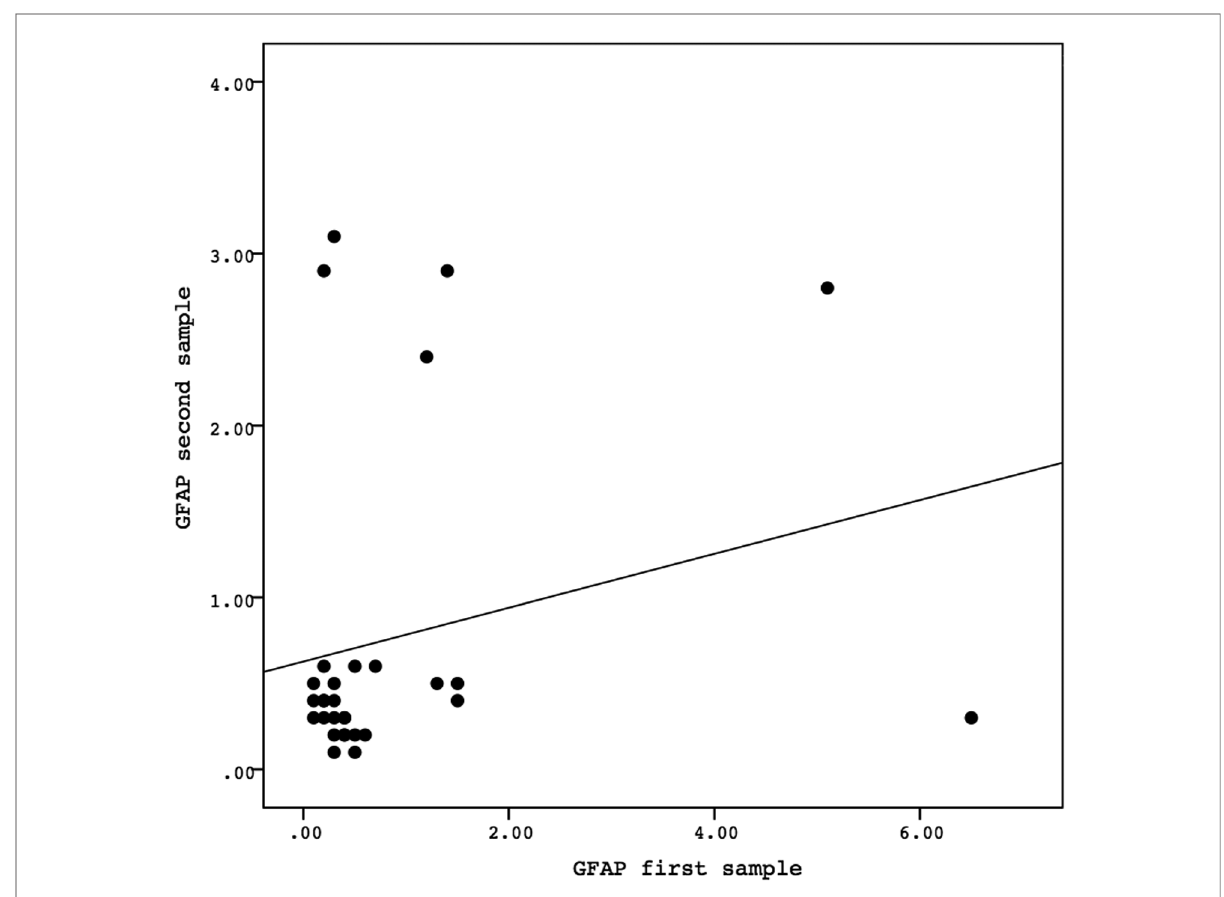
FIGURE 2 The correlation between the GFAP values of the fi rst sample and the second sample. Correlation analysis using Spearman correlation demonstrated the correlation coef fi cient ( r )=0.081 and P -value=0.669. GFAP, glial fi brillary acidic